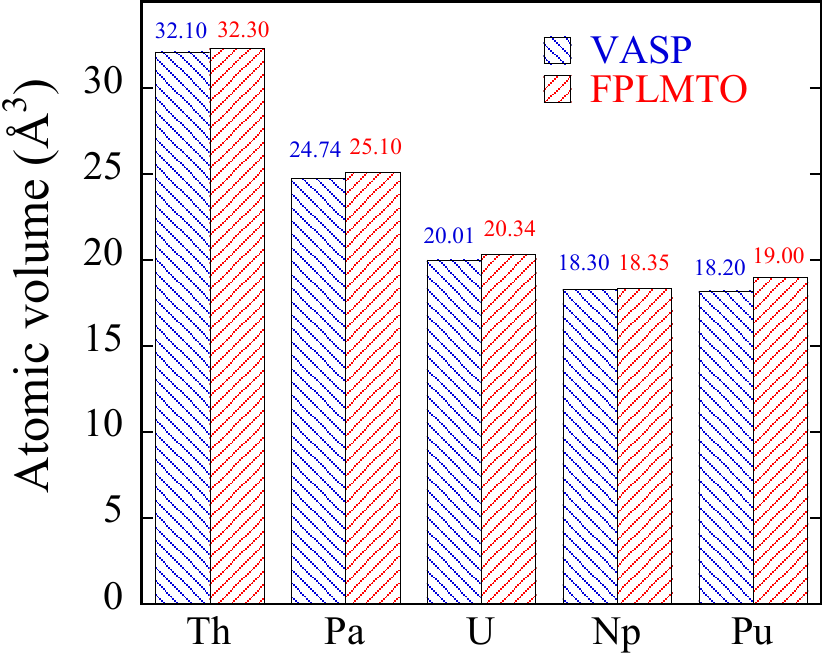
Figure 3. Scalar-relativistic (no spin–orbit coupling) atomic volumes for Th to Pu calculated with VASP and FPLMTO. Appl. Sci. 2019 , 9 , x FOR PEER REVIEW